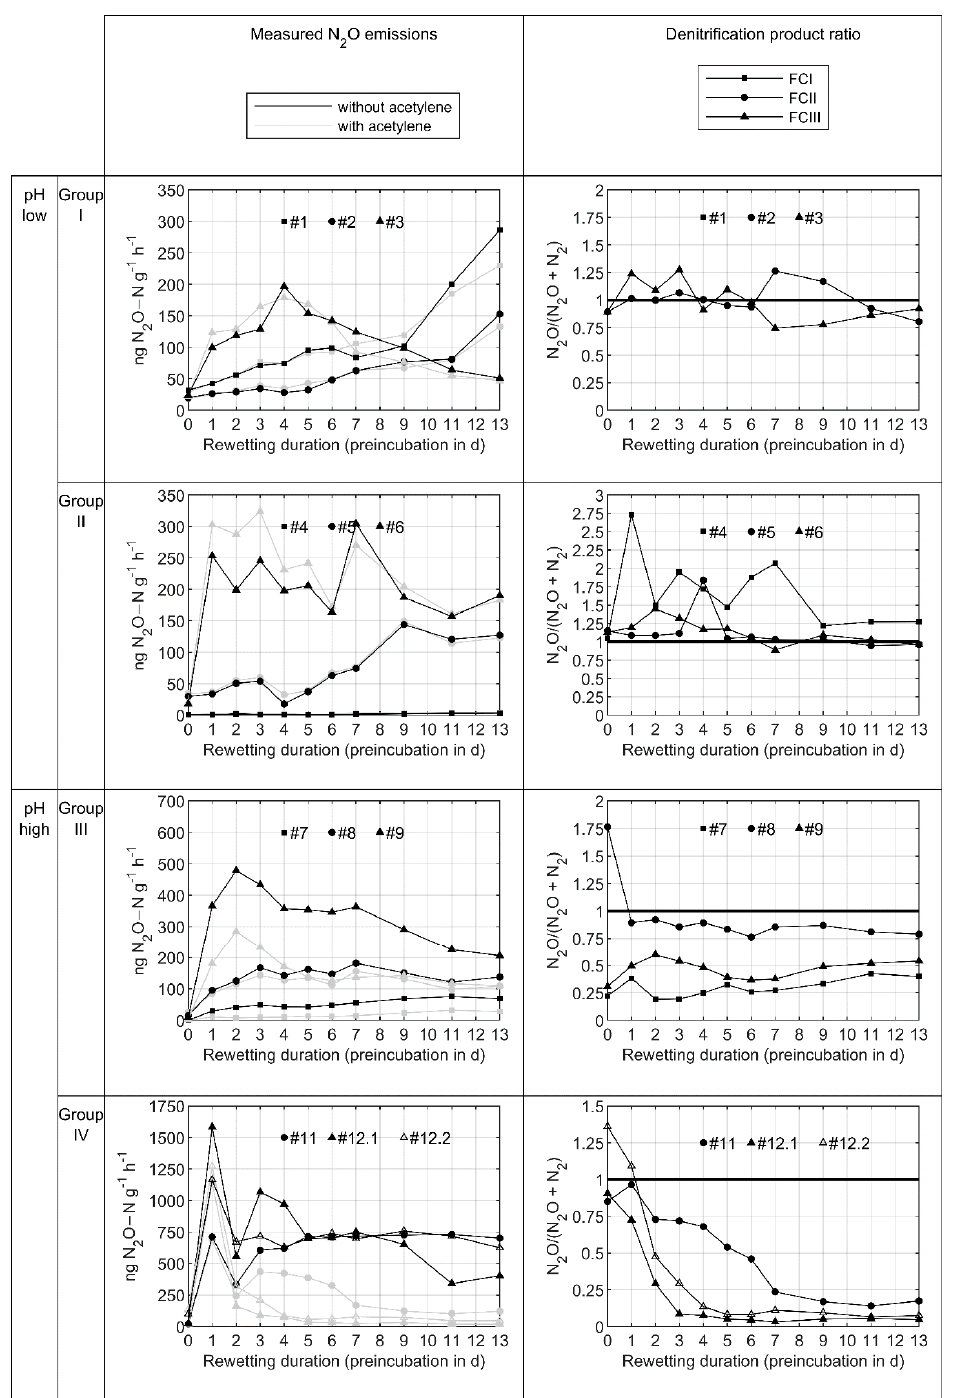
Figure 1. Measured N 2 O emissions in treatments with and without acetylene (left) and the Figure1. MeasuredN 2 Oemissionsintreatmentswithandwithoutacetylene(left)andthedenitrification denitrification product ratio (N 2 O/(N 2 O + N 2 )) calculated from them (right). For a detailed legend see product ratio (N 2 O / (N 2 O + N 2 )) calculated from them (right). For a detailed legend see Table Table 1.